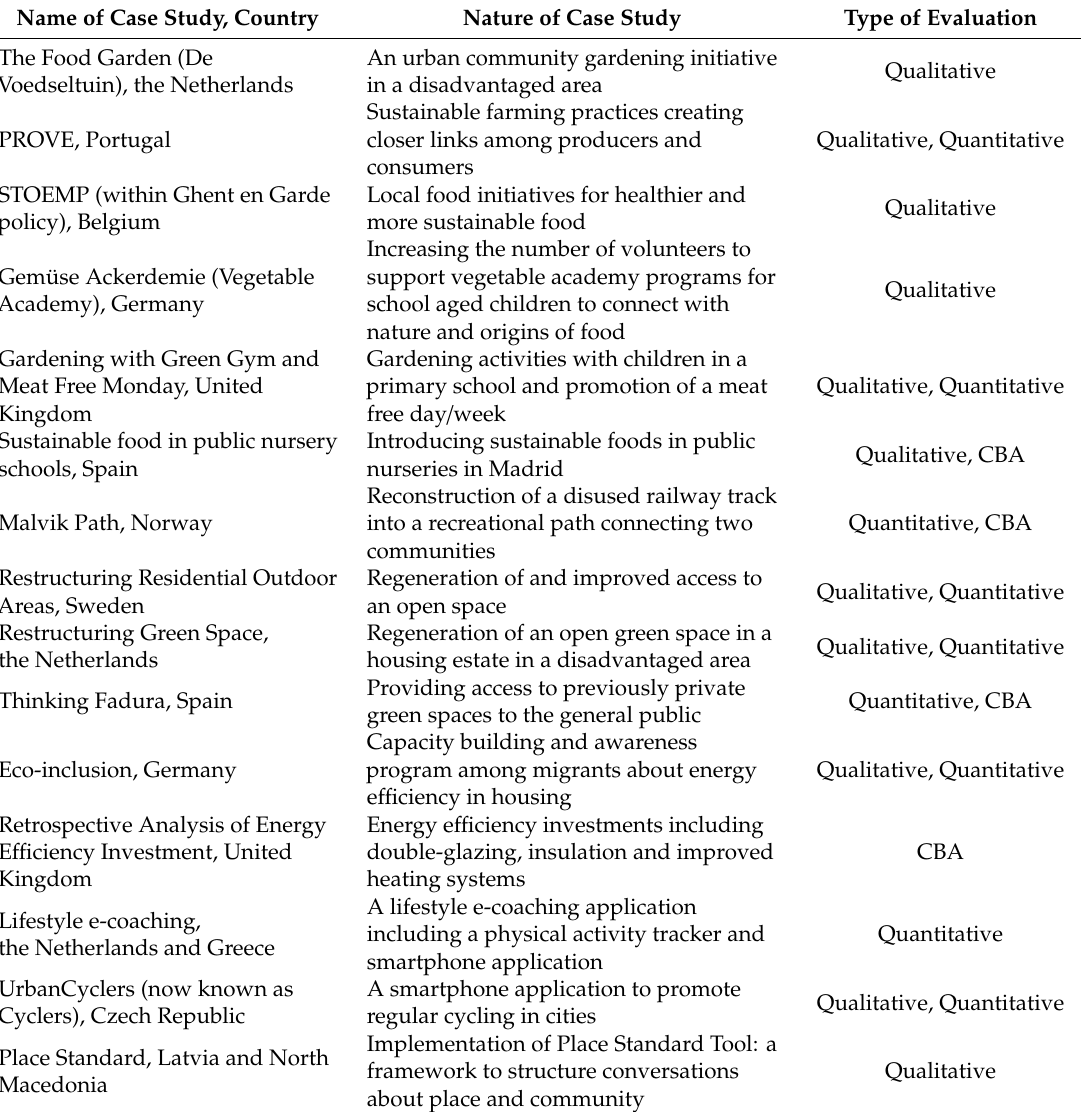
Table 1. Summary descriptions of the 15 INHERIT case